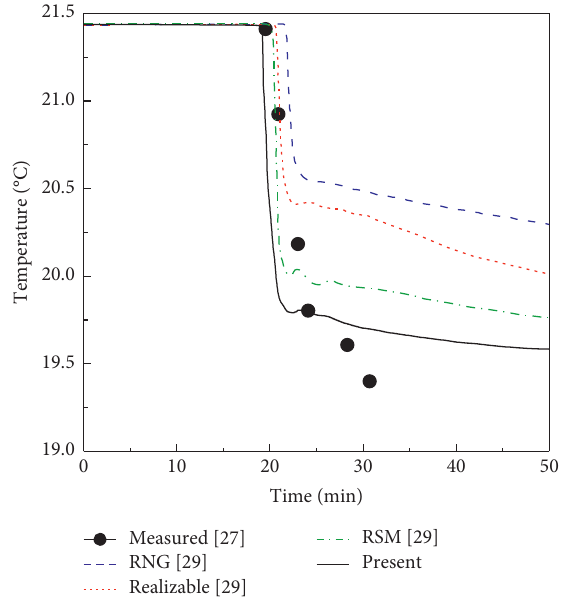
Figure 10: Histories of the discharge water and t � 11min on the symmetric plane temperature at the